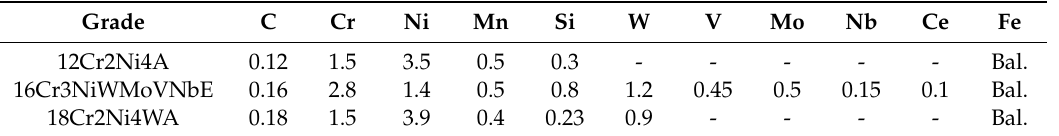
Table 1. Chemical compositions of the alloy steels (wt.%).